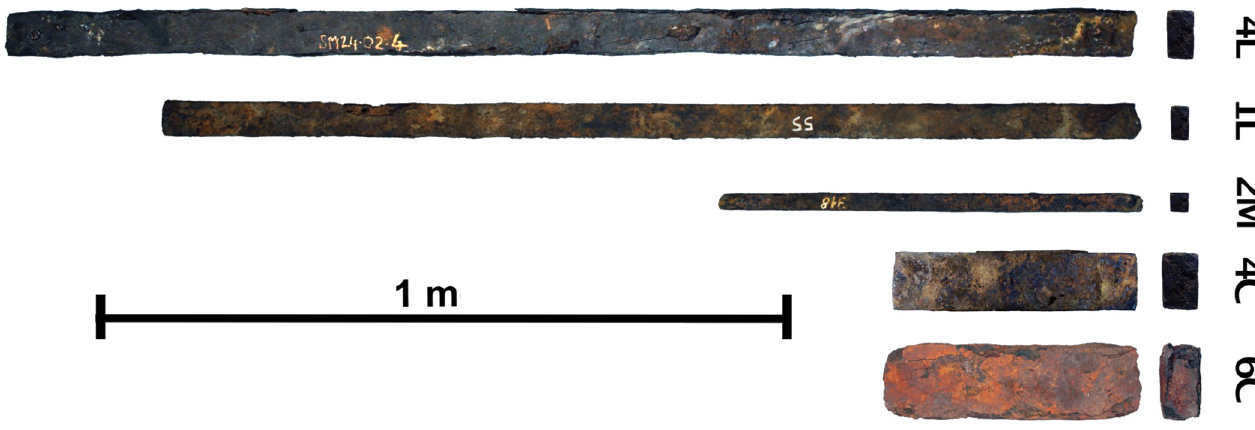
Fig 7. Bar types studied here. For further information on typology, see